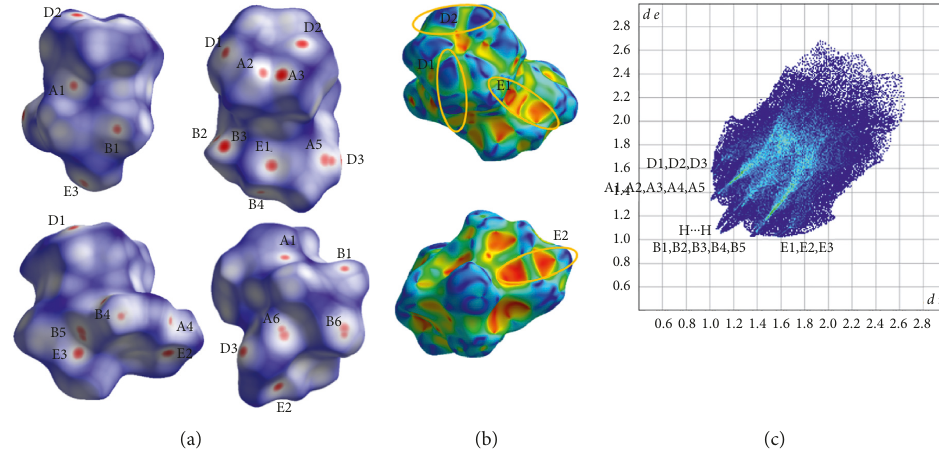
Figure 6: (a) Different views of the d norm decorated HS, (b) two views of the shape decorated HS and (c) fingerprint plot for the 2b complex. A1, A2, A3, A4, A5, A6 and B1, B2, B3, B4, B5, B6 are the donor and acceptor contact points of C 12 —H 12 B C 15 —H 15 A O 5 , C 6 —H 6 O 5 , C 8 —H 8 O 4 and C 9 —H 9 O 1 hydrogen bond interactions. E1, E2 and D1, D2 are the donor and acceptor · ·· · ·· · ·· · · · contact points involved in the C 13 -H